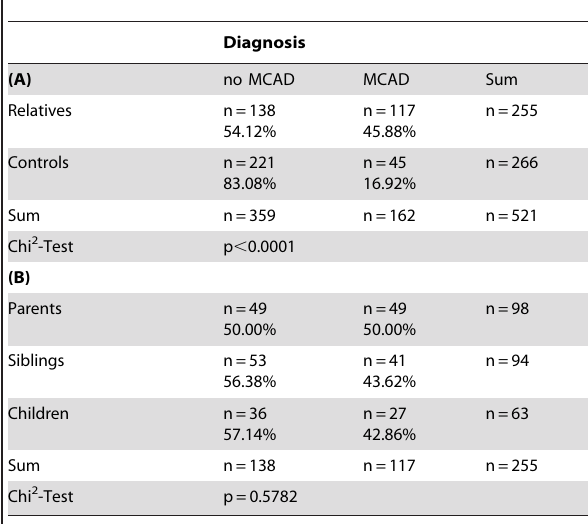
Table 2. Prevalence of MCAD in first-degree relatives and healthy subjects (A) and within the first-degree relatives group